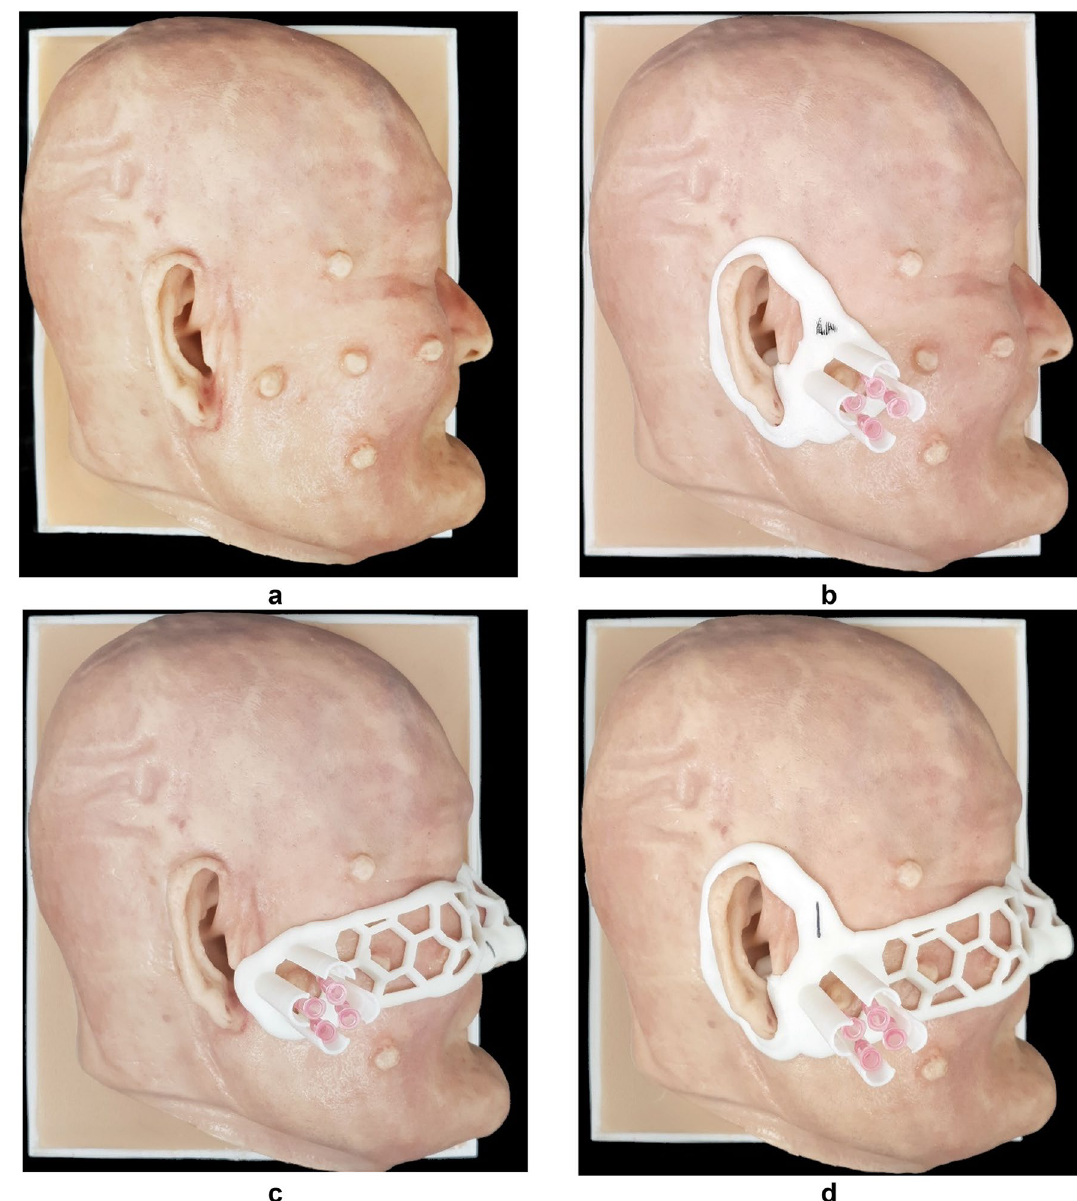
Figure 1. Fabricated in-vitro phantom and inserted 16 cc intravenous (IV) catheter using the skin cancer resection guide. ( a ) Fabricated in-vitro phantom. ( b ) Inserted 16-cc IV catheters into in-vitro phantom using skin cancer resection guide attached at the ear. ( c ) Inserted 16-cc IV catheters into in-vitro phantom using skin cancer resection guide attached at the nose. ( d ) Inserted 16-cc IV catheters into in-vitro phantom using skin cancer resection guide attached at both the ear and